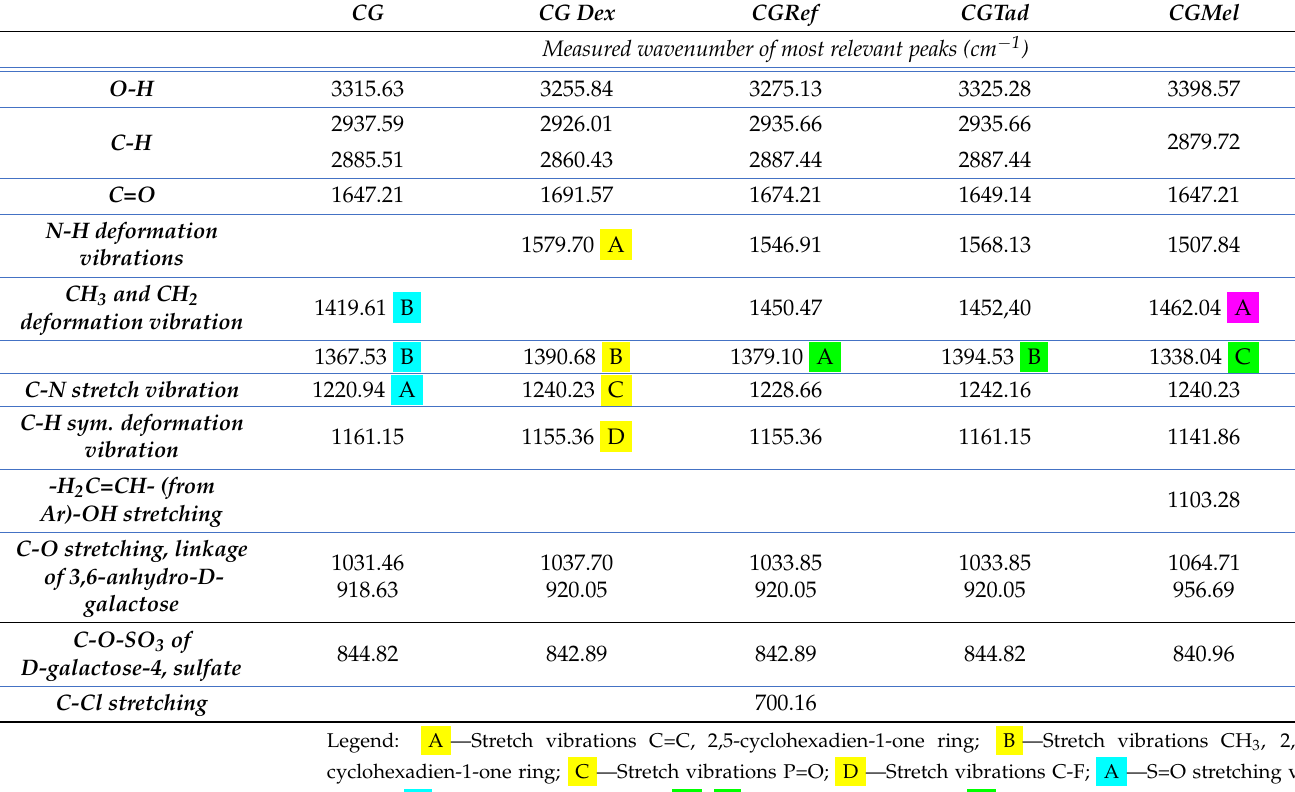
Table 2. Wavenumber values of most relevant peaks found in FT-IR spectra of analyzed